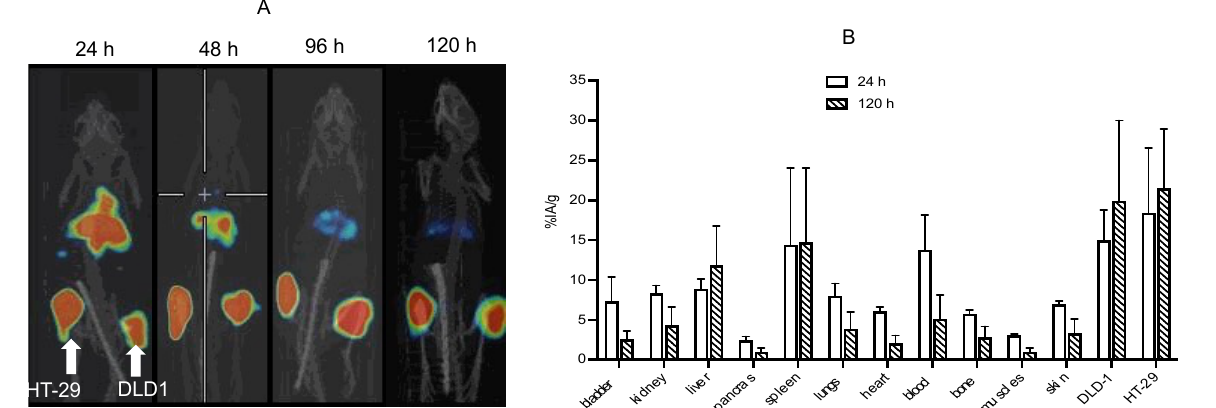
Figure 5. Biodistribution of 89 Zr-matuzumab in athymic CD-1 nude mice. ( A ) Mice bearing DLD-1 (left flank)/HT-29 (right flank) xenografts at 24 and 120 h following injection of 89 Zr-matuzumab. ( B ) Mice bearing an MDA-MB-231 xenograft were pre-dosed with a large excess (50-fold of the imaging dose) of unlabeled matuzumab 24 h prior to a tail vein injection of 89 Zr-matuzumab. ( C ) Mice bear- ing SW620 xenografts at 24 and 120 h following injection of 89 Zr-matuzumab.